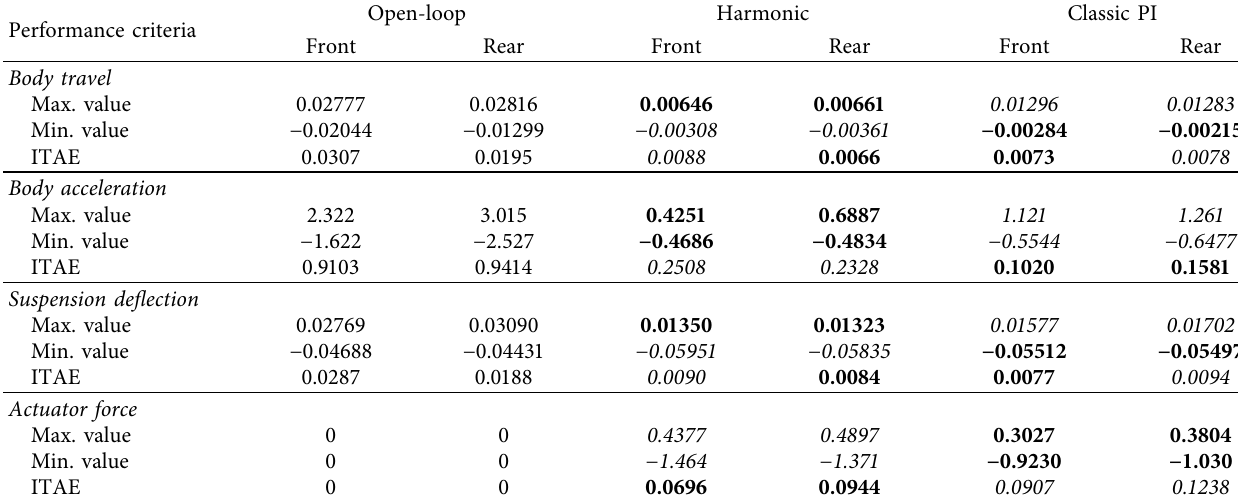
Table 2: Performance criteria of body travel, body acceleration, suspension deflection, and actuator force. Performance